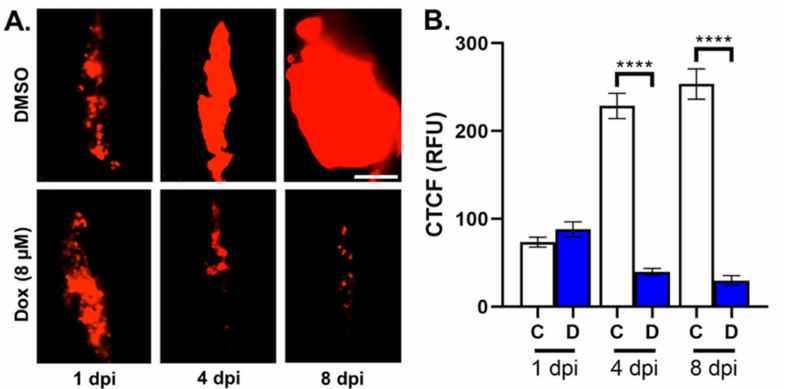
Figure 4. Doxorubicin treatment decreased tumor area compared to DMSO vehicle in zebrafish MDA-MB-231 TNBC xenografts. ( A ). Top row: images showing the area occupied by MDA-MB-231- Luc/RFP TNBC cells in zebrafish xenograft samples treated with DMSO vehicle at 1, 4, and 8 days postinjection; bottom row: images showing the area occupied by MDA-MB-231-Luc/RFP TNBC cells in zebrafish xenograft samples treated with 8 µ M doxorubicin at 1, 4, and 8 dpf. ( B ). Measurement of corrected total cell fluorescence for DMSO-treated samples (white columns) and doxorubicin-treated samples (blue columns) at 1, 4, and 8 dpi. Key: CTCF = corrected total cell fluorescence; RFU = relative fluorescence units; Dox = doxorubicin. N = 3 biological replicates with 26–30 total technical replicates. “****” = p < 0.0001; Error bars = SEM. Scale bar = 200 µ